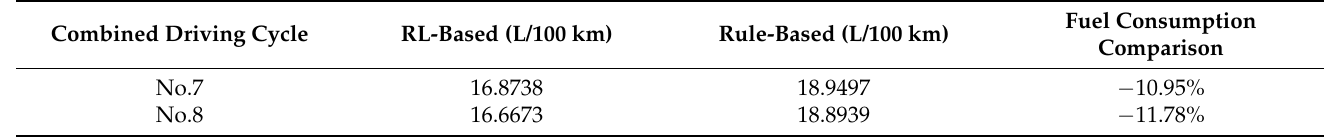
Table 1. The fuel consumptions of the off-line verification.